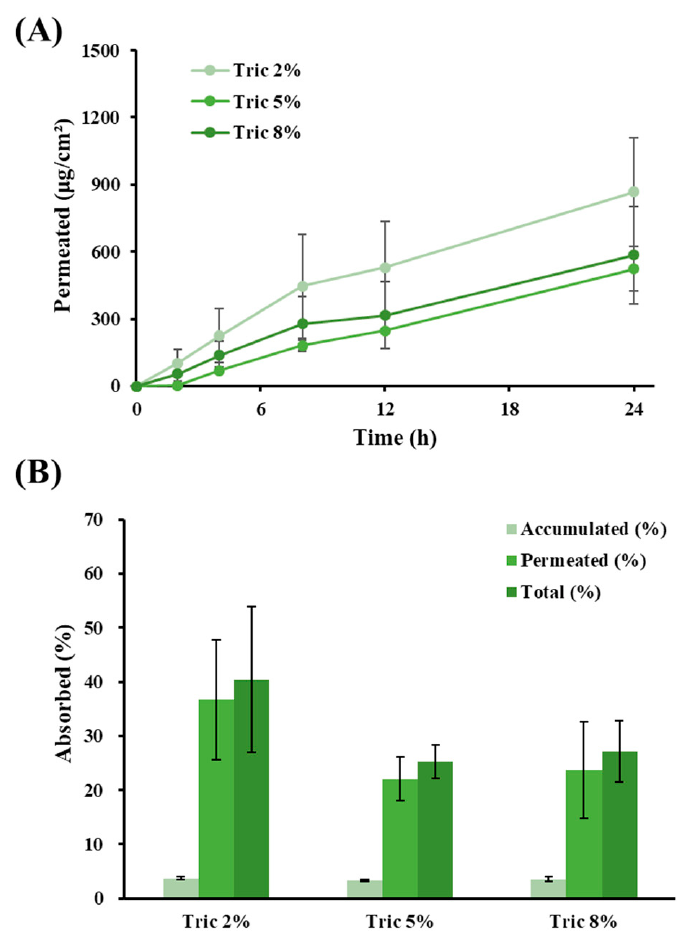
Figure 6. Ex vivo skin absorption of Vit C after topical administration of LOSs prepared with different amounts of oil. ( A ) Skin permeation profile ( µ g/cm 2 ) of Vit C across porcine skin. ( B ) Percent of Vit C accumulated in the skin, permeated across the skin, and the sum of Vit C accumulated and permeated 24 h post-administration of LOSs. LOSs prepared with a tricaprylin concentration of 2% (L5), 5% (L6), and 8% (L7) were named Tric 2%, Tric 5%, and Tric 8%, respectively. Total absorbed (%) is calculated by dividing the accumulated amount, and the permeated amount of Vit C by the initially applied amount of Vit C. Data represent mean ± SD (n = 3).